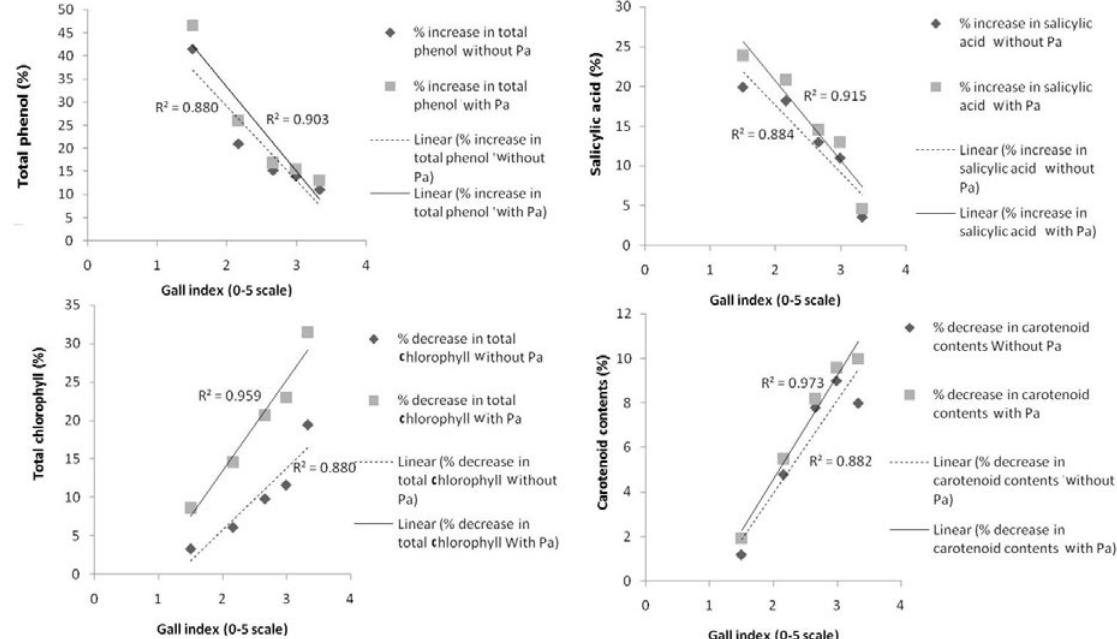
Figure 4. Correlations between nematode gall indices and percent variation in phenolic content, salicylic acid, total chloro- phylls and carotenoids in tobacco cultivars inoculated with Meloidogyne incognita